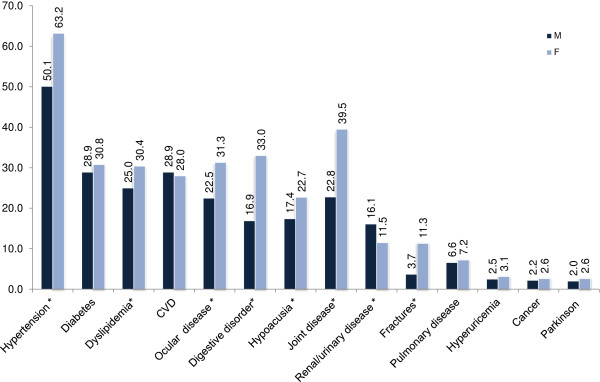
Prevalence (%) of comorbidities distributed by gender (AMEL study, N=1200).